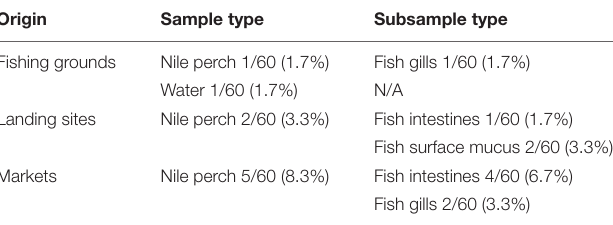
TABLE 1 | Prevalence of ESBL-producing Escherichia coli in water and Nile perch from Lake Victoria, Tanzania. Origin